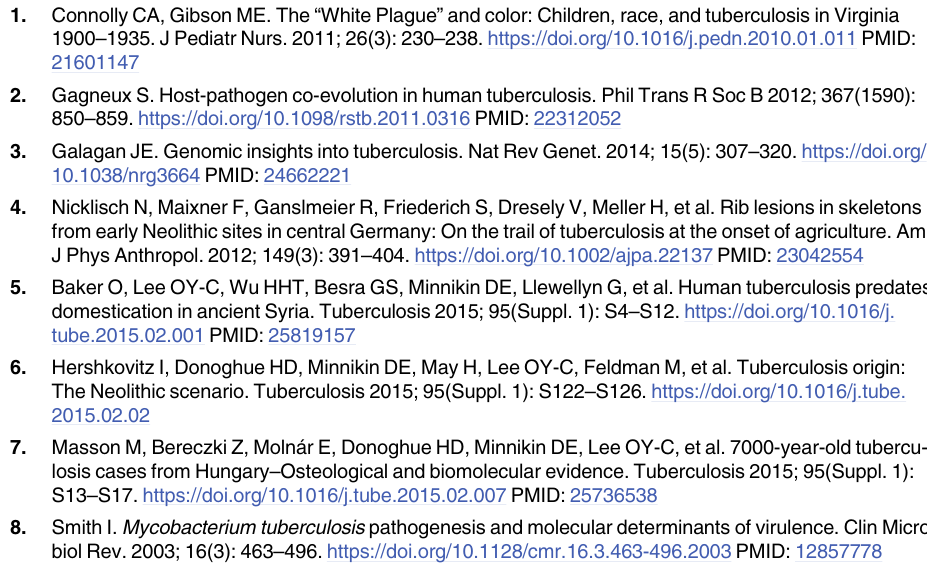
S12 Table. Individual data of cases exhibiting PAs on the inner skull surface regarding pos- sible TB-related non-endocranial bony changes in the NTB group ( S = 20). (NTB = non- tuberculous; PAs = periosteal appositions; PNBFs = periosteal new bone formations; HPO = hypertrophic pulmonary osteopathy; + = present; − = not